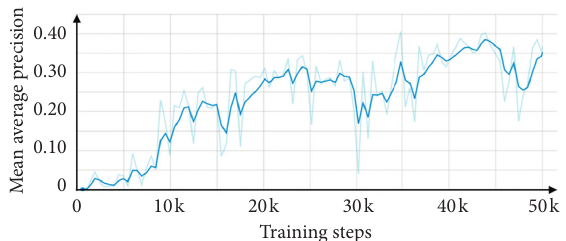
Figure 6: Mean average precision change during